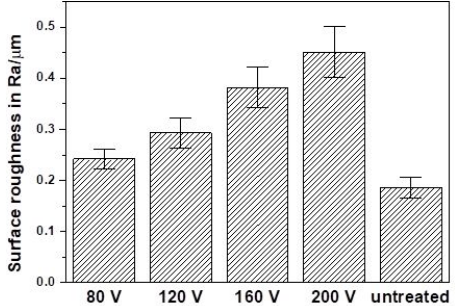
Figure 6. Surface roughness of the samples untreated and subjected to MAO treatment applied various